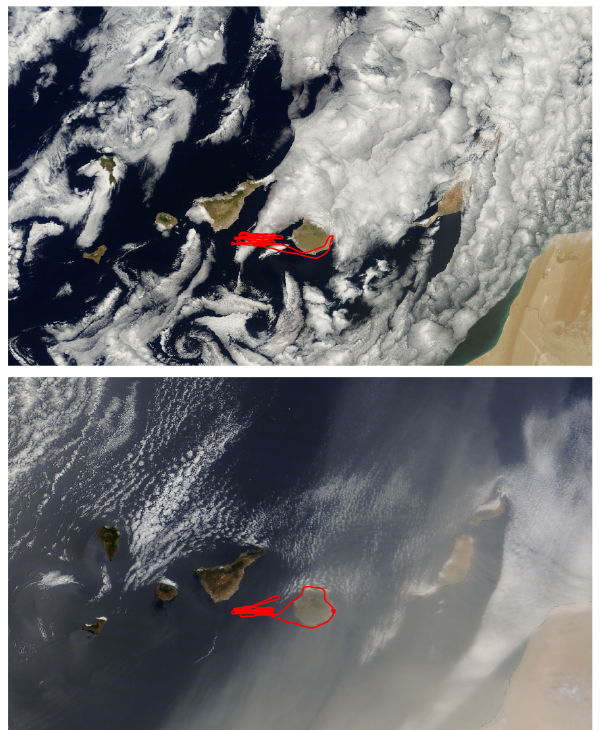
Figure 8. Satellite images of the Canary Islands of 21 July 2013 (top) and 31 July 2013 (bottom), which are representative of “North Atlantic” and “Sahara” conditions, respectively (for an explanation see Sect. 3.3). Images are daily composites of data of the Moderate Resolution Imaging Spectroradiometer (MODIS) aboard the NASA Terra and Aqua satellites (source: https://earthdata.nasa.gov/labs/ worldview/). The aircraft flight tracks are depicted as red